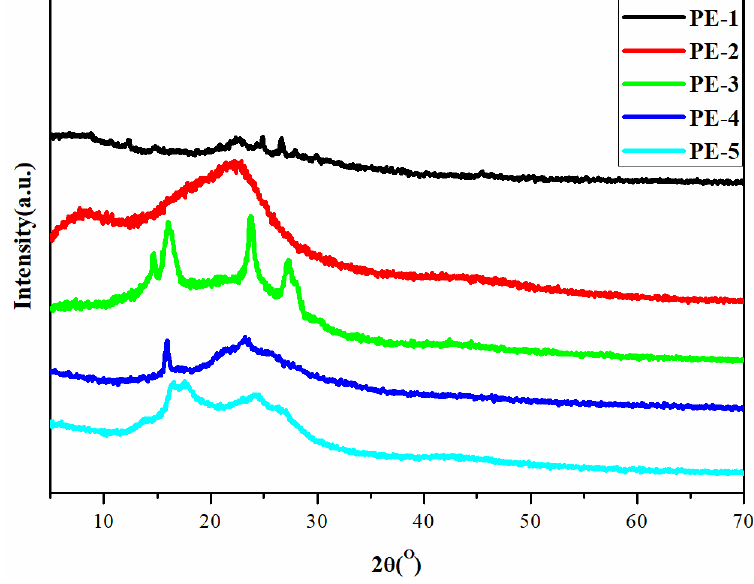
Figure 5. XRD curves of PEs.